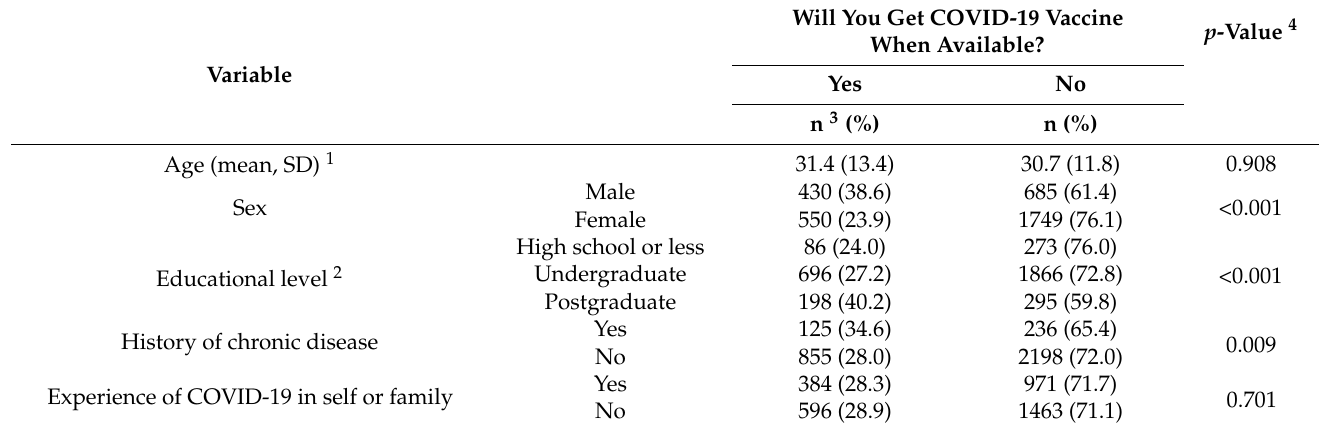
Will You Get COVID-19 Vaccine When Available?